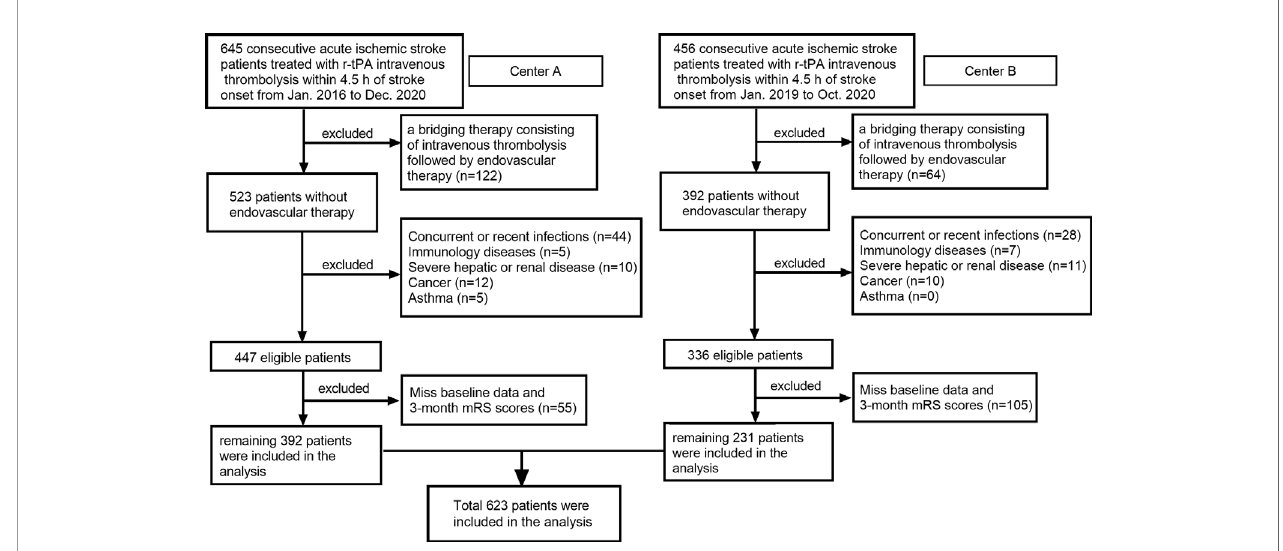
FIGURE 1 | Flow chart for patients ’ selection. Center A: Third Af fi liated Hospital of Wenzhou Medical University; Center B: First Af fi liated Hospital of Wenzhou Medical